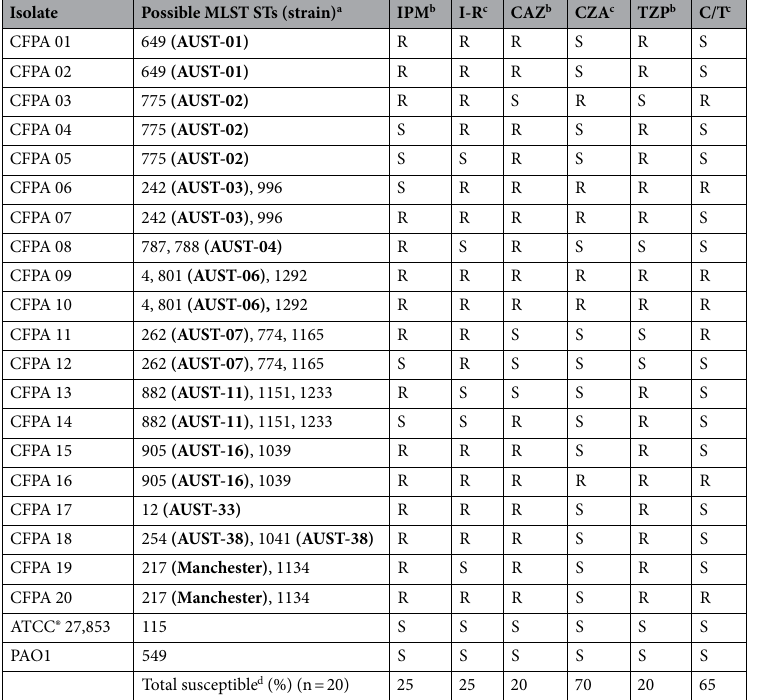
Table 2. Genotypes and AMR phenotypes of isolates used in this study. IPM imipenem, I-R imipenem/ relebactam, CAZ ceftazidime, CZA ceftazidime/avibactam, TZP piperacillin/tazobactam, C/T ceftolozane/ tazobactam. a Genotypes (MLST STs) associated with the iPLEX20SNP profile. Named strains associated with genotypes indicated in bold. b Susceptibility determined by disk diffusion assay. c Susceptibility determined by broth microdilution assay. d Excludes reference strains P. aeruginosa ATCC® 27,853 and P. aeruginosa